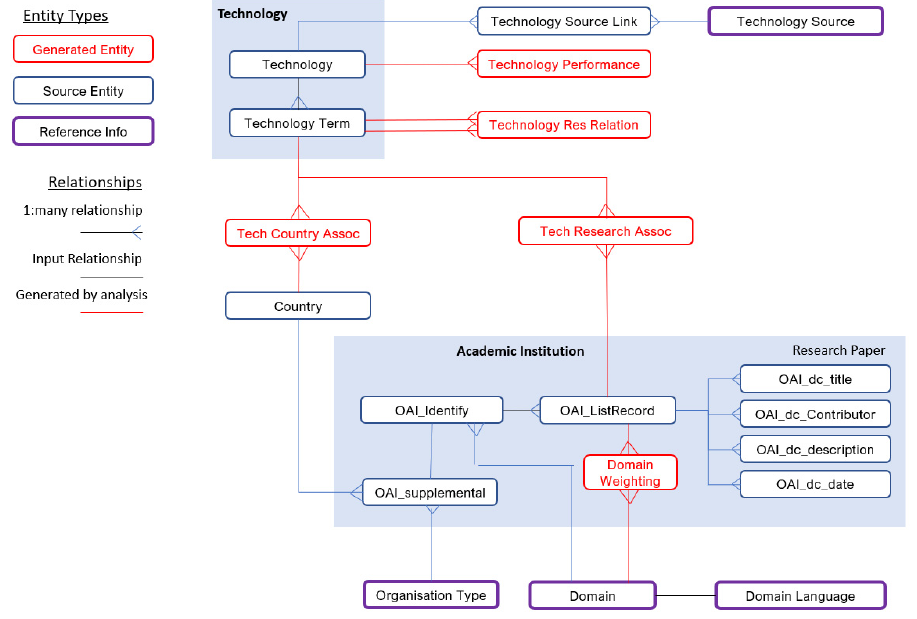
Figure 6. Experiment Database Design.